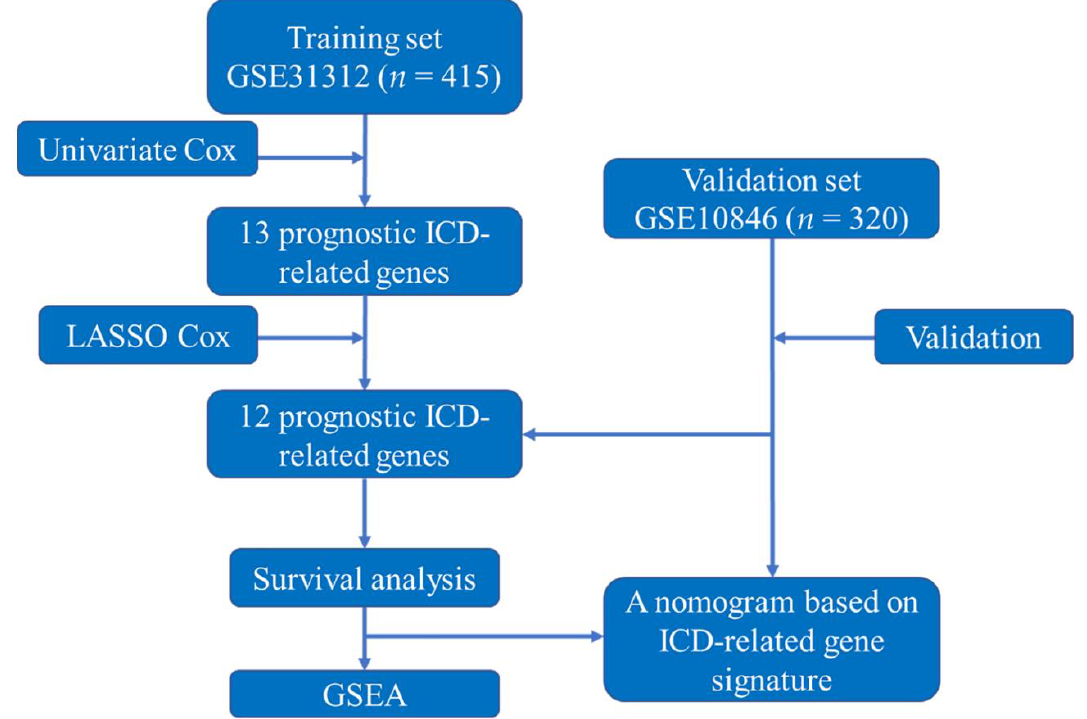
Figure 1. The study’s design and flowchart. Abbreviations: ICD, immunogenic cell death; LASSO, Figure 1. The study ’ s design and flowchart. Abbreviations: ICD, immunogenic cell death; LASSO, least absolute shrinkage and selection operator; GSEA, gene set enrichment analysis. least absolute shrinkage and selection operator; GSEA, gene set enrichment